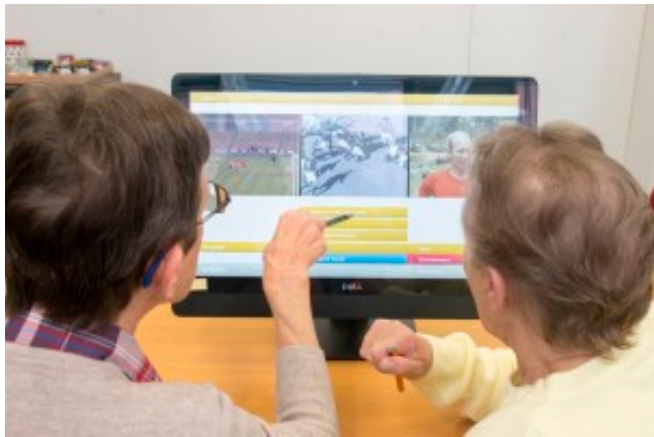
Figure 2. The original CIRCA being enjoyed.